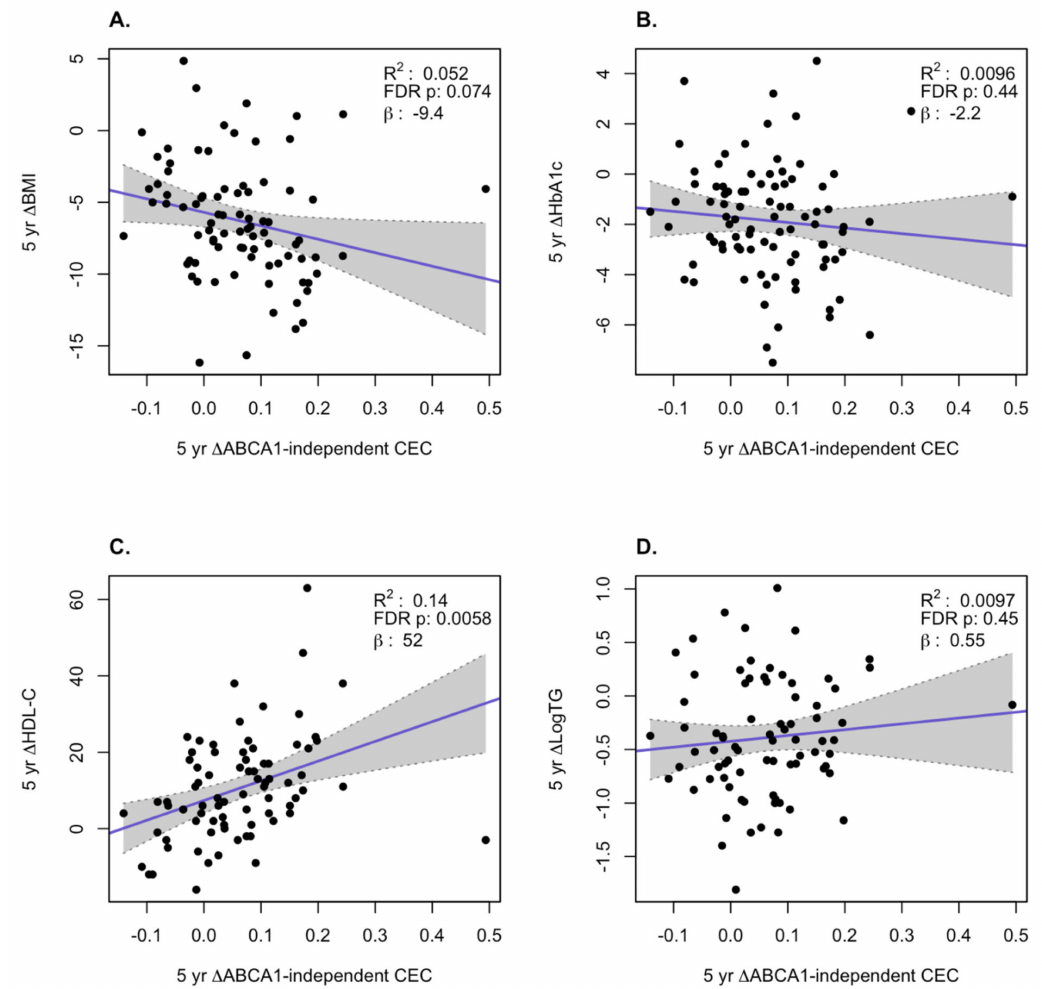
Figure 5. Correlation of changes of ABCA1-independent CEC with changes in clinical variables at 5 years. Changes in BMI ( A ), HbA1c ( B ), HDL-C ( C ), and log TG ( D ). The gray region is the 95% confidence